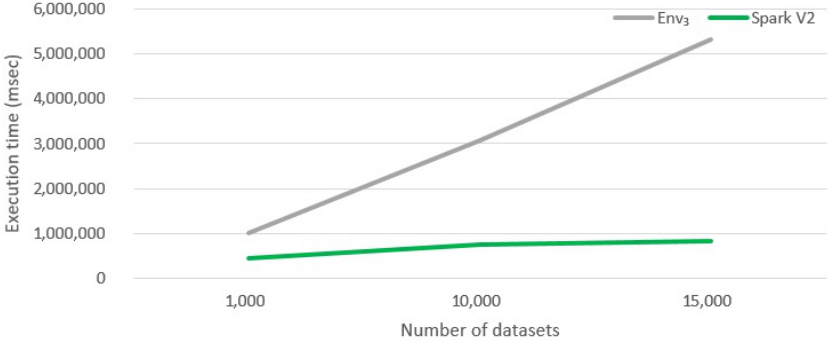
Figure 7. Comparing average execution times of the basic Spark implementation (denoted as Env 3 ) and the enhanced Spark implementation (denoted as Spark V2